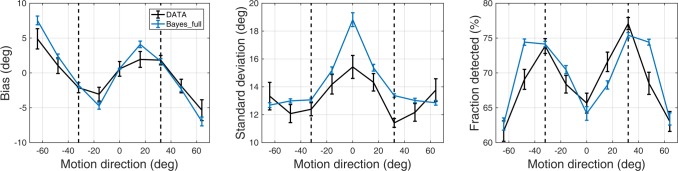
Task performance as predicted by the BAYES_full model.Left panel: mean estimation bias at different motion directions. Middle panel: standard deviation of estimations at different motion directions. Right panel: fraction of detected stimuli at different motion directions. The dashed lines correspond to the two most frequently presented motion directions (±32°). Error bars represent within-subject standard error.